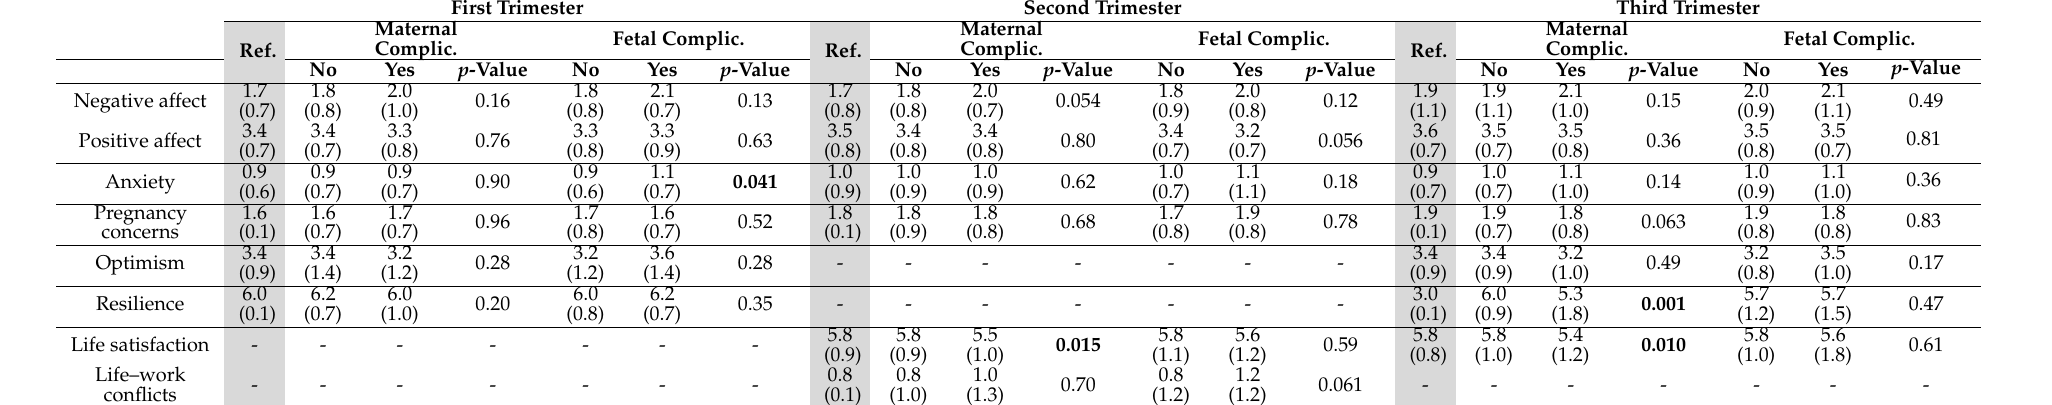
Table 3. Psychological variables according to maternal ( n = 84) and fetal ( n = 45) complications. First Trimester Second Trimester Third